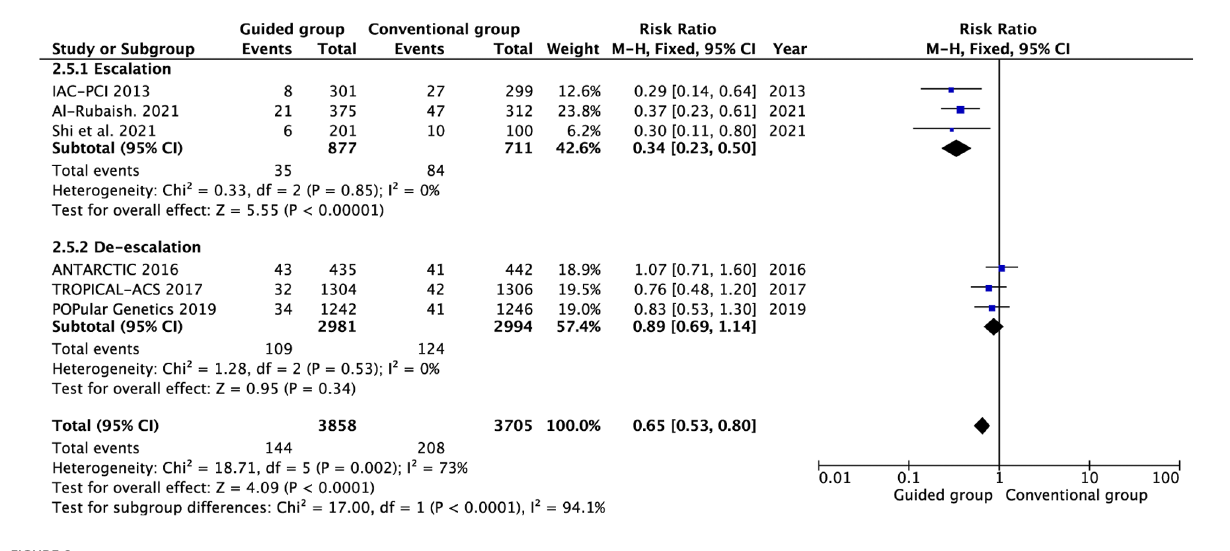
FIGURE 2 Pooled analyses of guided vs. standard antiplatelet therapy for the primary